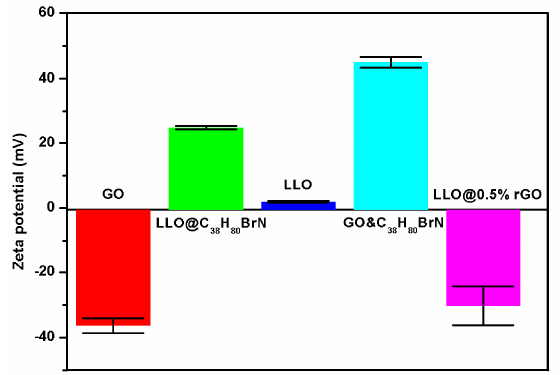
Figure 2. Potentials of pristine layered lithium-rich manganese oxide (LLO), LLO modified with a surfactant, and graphene-oxide (GO) sheets in aqueous solutions. Dimethyldioctadecylammonium bromide was used as the surfactant.